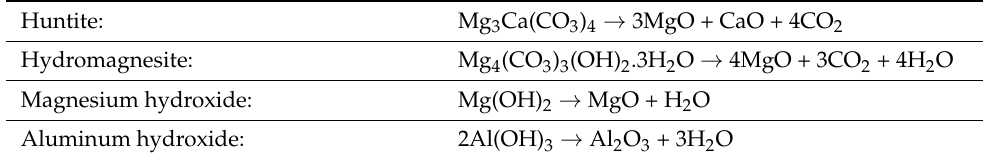
Table 1. Flame-retardant reactions of huntite, hydromagnesite, ATH, and MH.